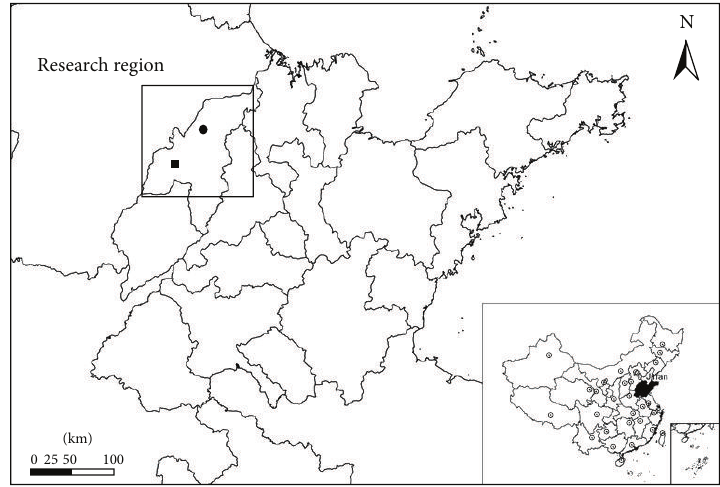
Figure 2: The schematic positions of Yucheng site ( e ), Lawn site ( ◼ ), and research range ( ◻ ).